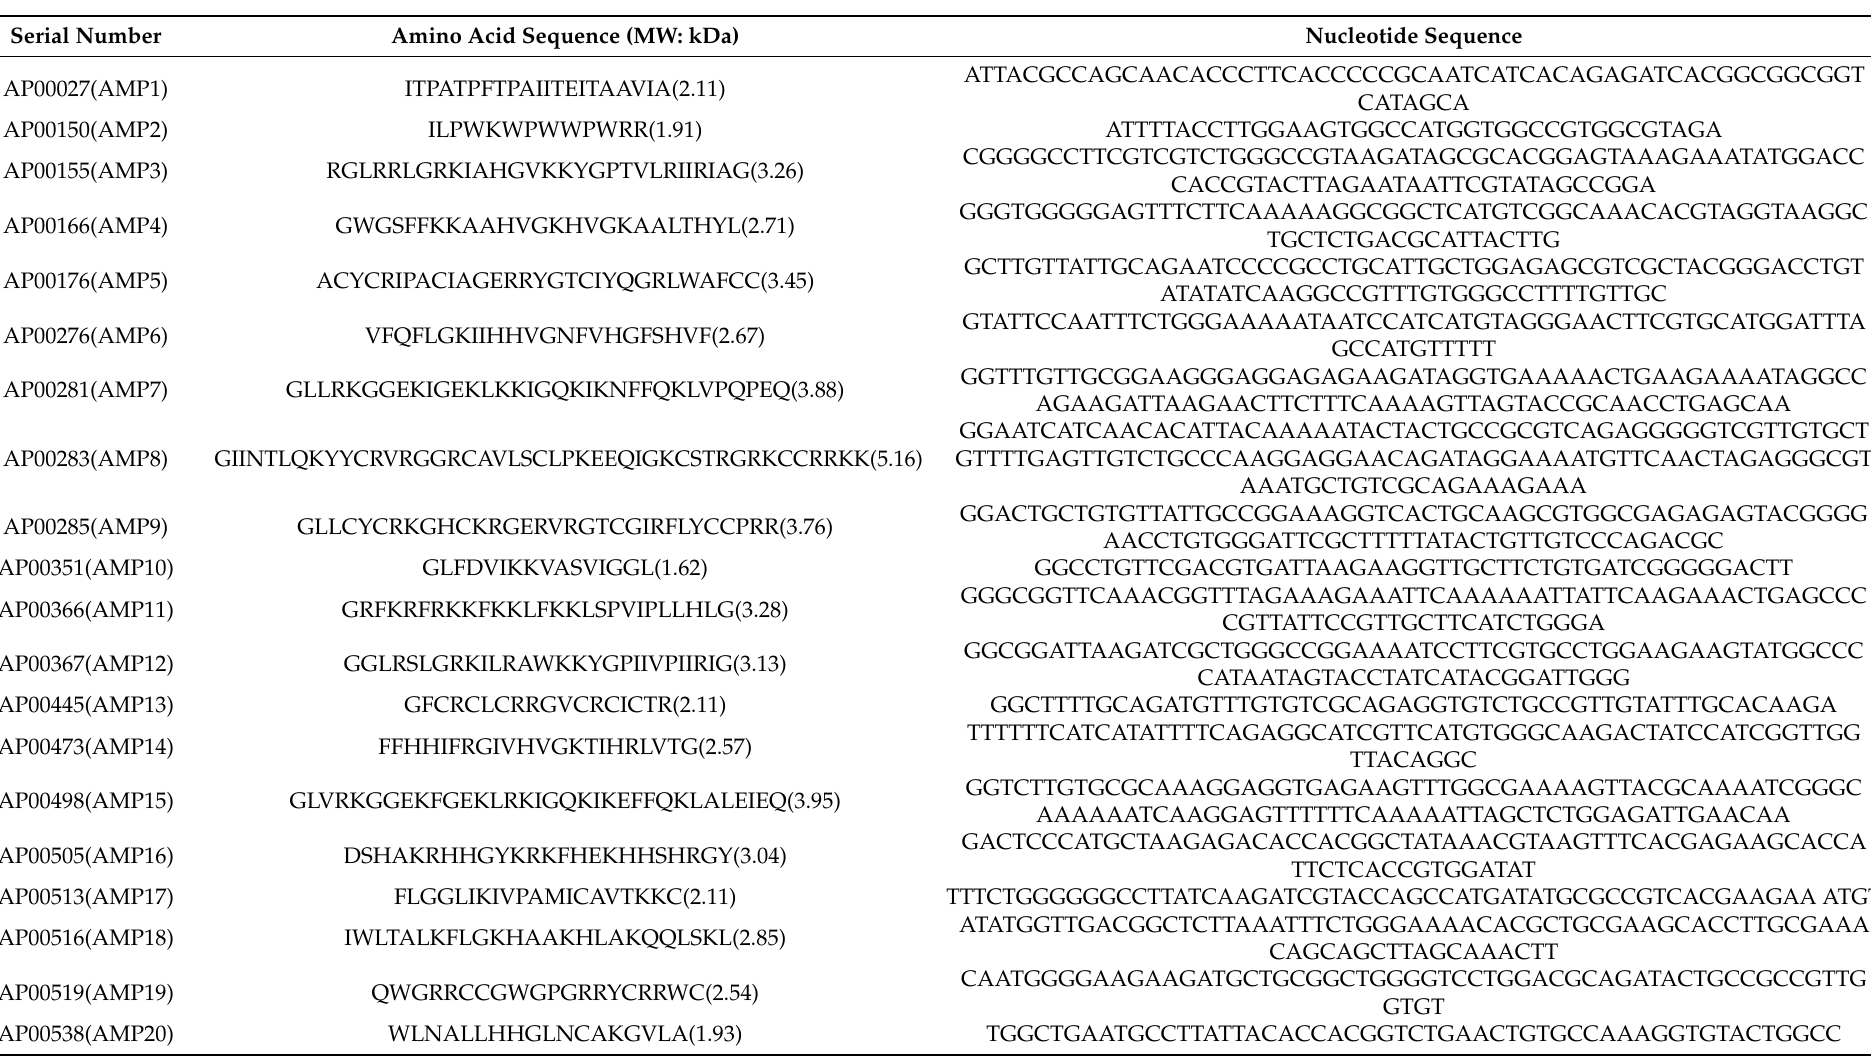
Table 1. Sequences of